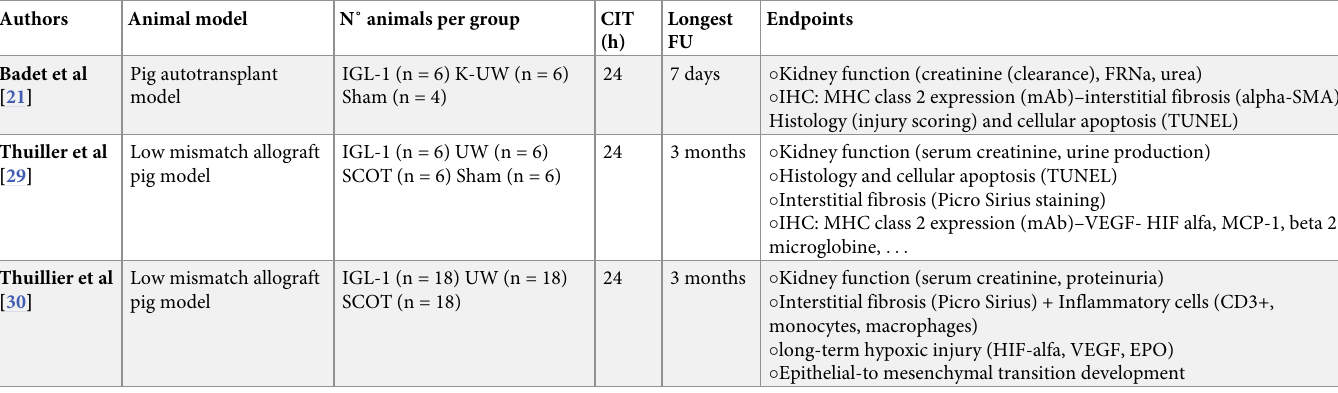
Table 3. Overview of outcome measures for the animal articles reporting on kidney